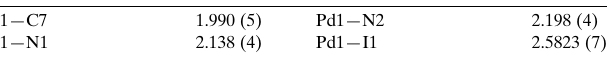
Selected bond lengths (A˚ ).